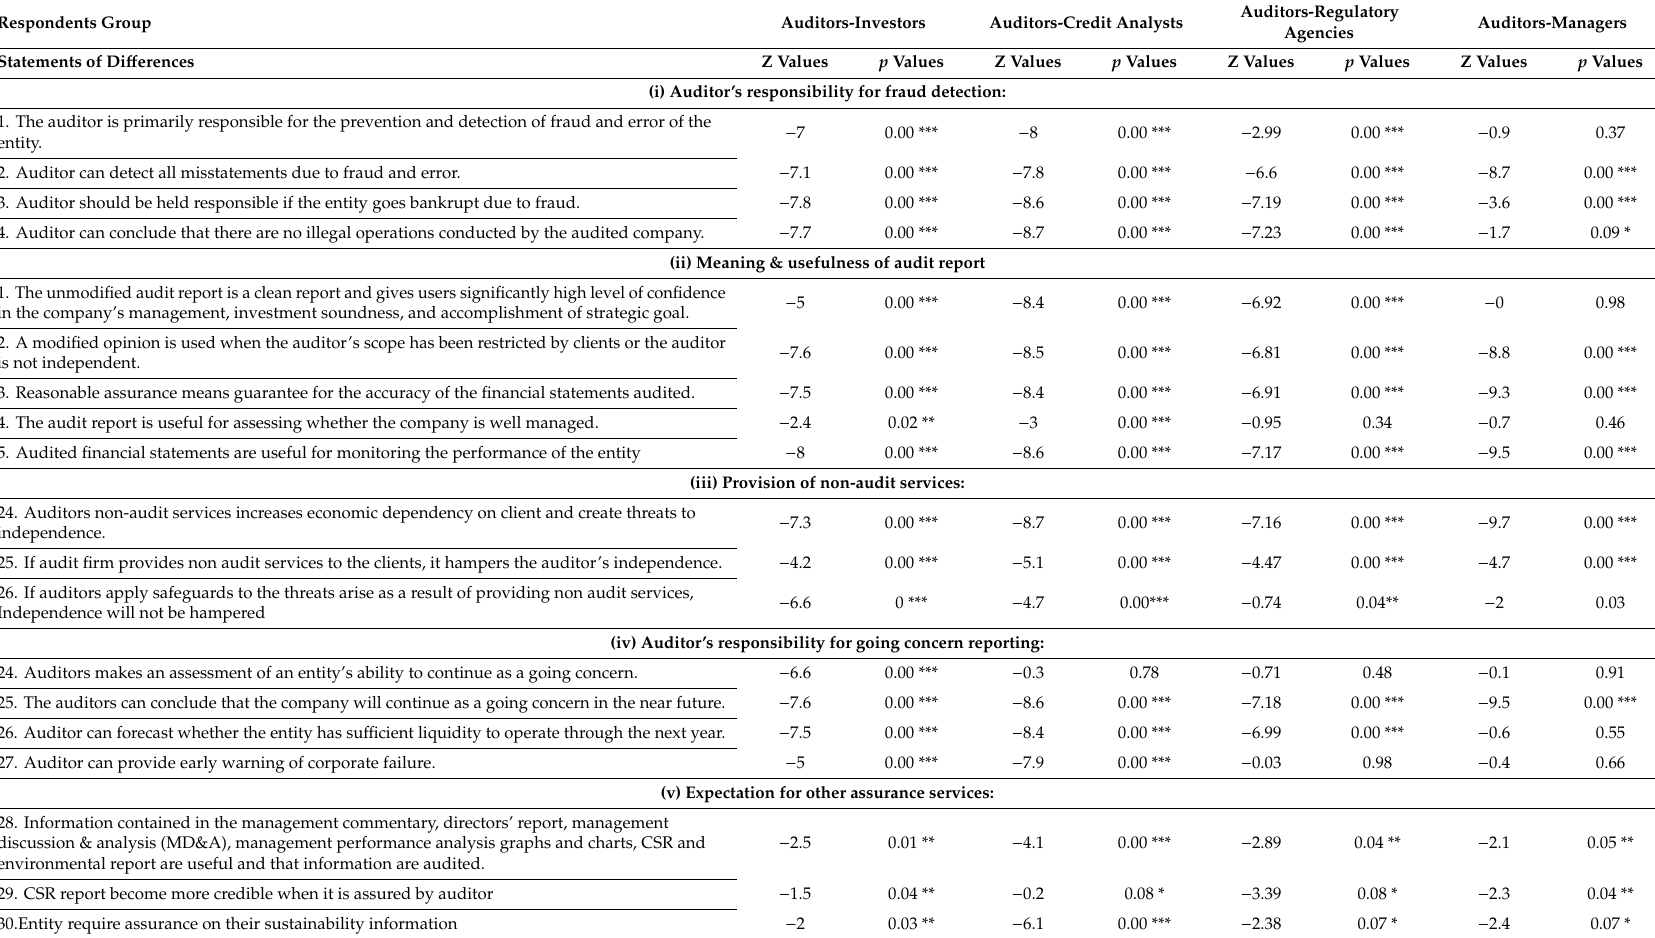
Table A2. Measurement of Audit Expectation gap. Note: The significant p values in the Mann-Whitney-U test is regarded as the presence of audit expectation